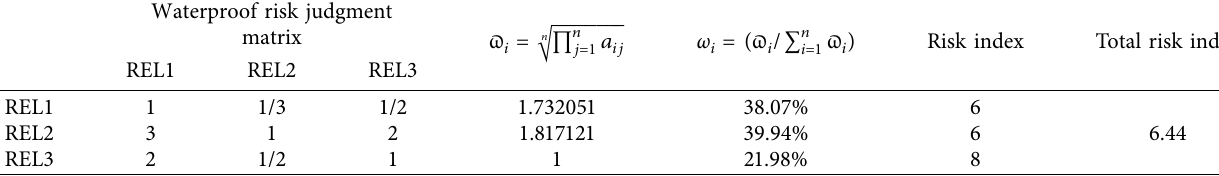
Table 31: Waterproof risk judgment matrix.